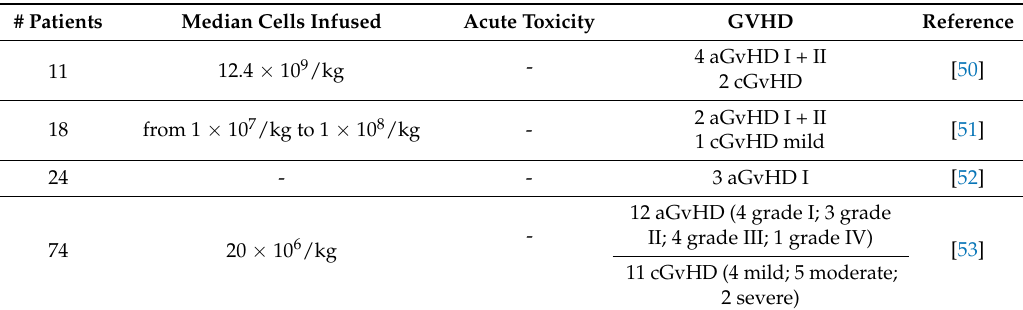
Table 1. Most relevant clinical studies with allogeneic CIK